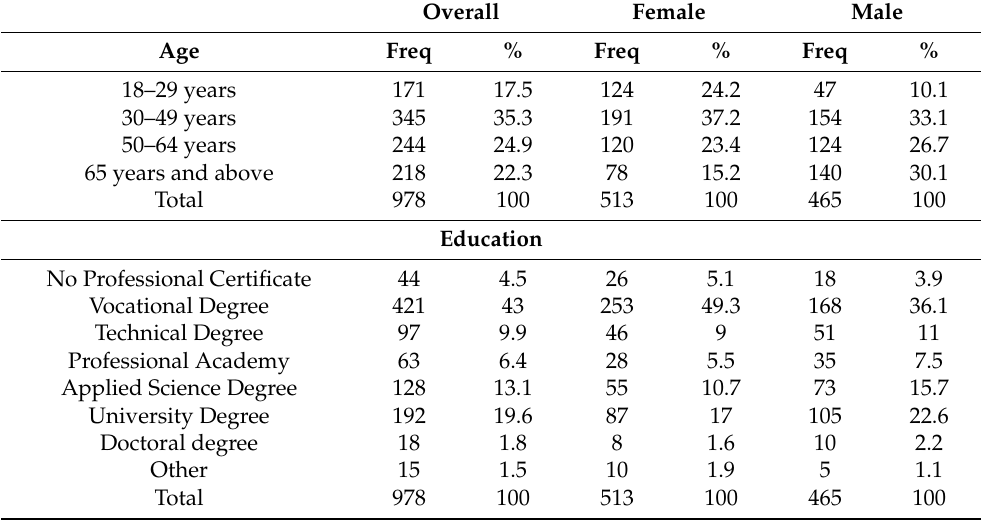
Table 1. Sample Description and Single Item